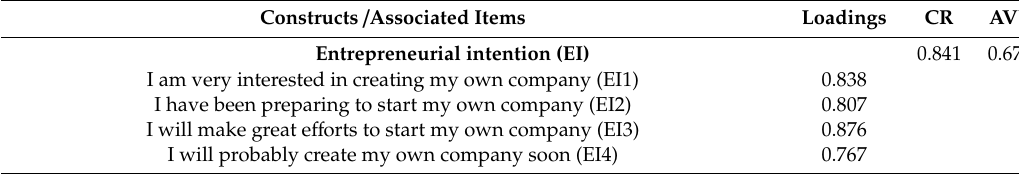
Table 4. Analysis of the measurement